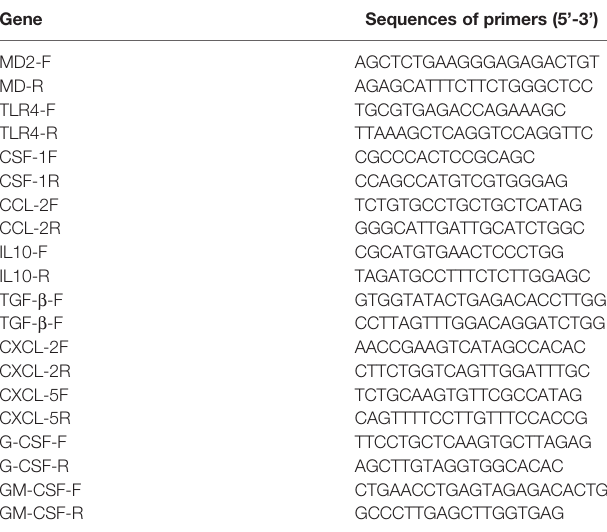
TABLE 1 | The primer sequences of indicated genes for qRT-PCR